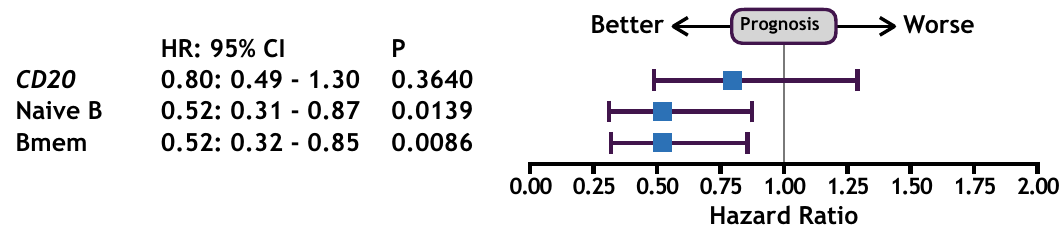
Fig. 5 The B cell signatures based on the single-cell RNA-seq results are signi fi cantly associated with improved survival in TNBC patients and provide better prognostication than classic single B cell markers. a Kaplan – Meier survival curves for the overall survival (left panels) and disease-free survival (right panels) of METABRIC TNBC patients according to single gene expression ( CD20 ) or combined gene transcription signatures (naive B cells and memory B cells). The 279 TNBC patients were sorted according to the expression levels of the gene or gene signatures, and the top 33% ( n = 92) vs. bottom 33% ( n = 92) of patients were used to generate survival curves ( “ Methods ” ). The p values were calculated by the two-sided log-rank test. b Prognostic effect of CD20 , naive B signature, and memory B signature in METABRIC TNBC patients. Forest plot shows HRs (the center blue squares) and 95% con fi dence intervals (horizontal ranges) derived from Cox regression survival analyses of disease-free survival in multivariable analyses adjusted for lymph node status, tumor size, age at diagnosis, and histological grade. Data were presented as HR and 95% con fi dence